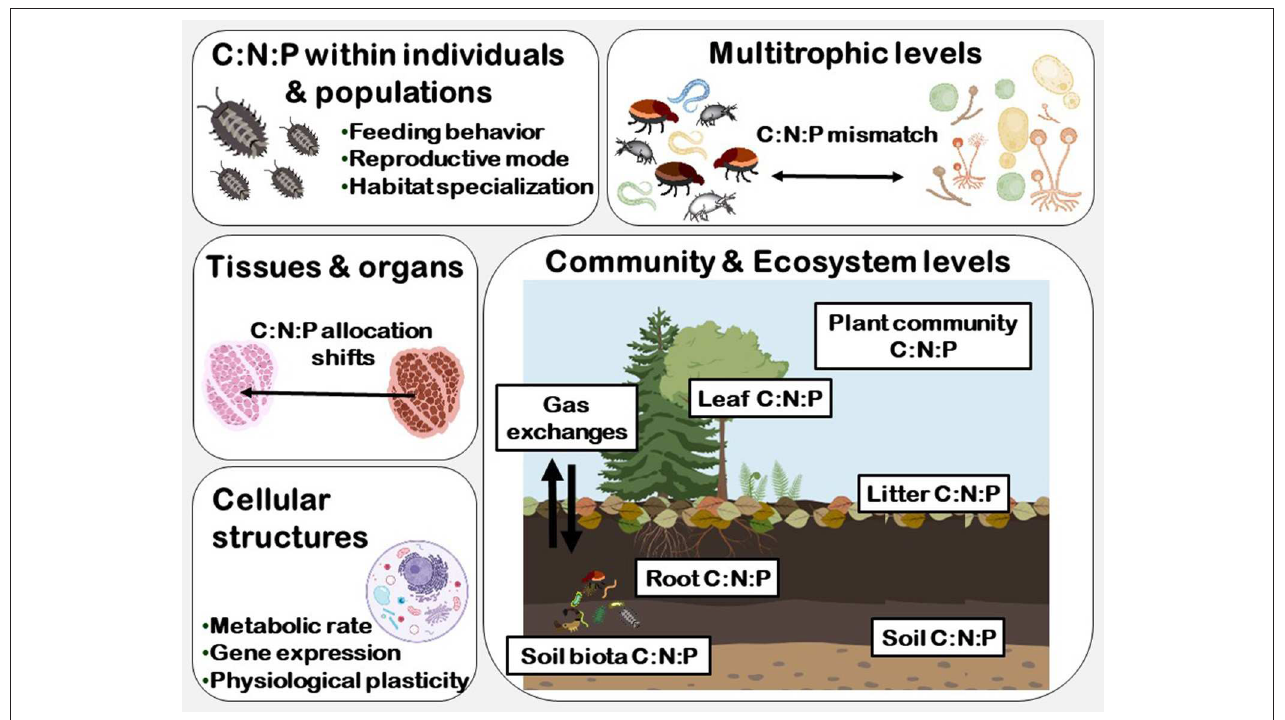
FIGURE 1 | The different biological levels of organization and the relationships of the carbon: nitrogen: phosphorus stoichiometry of primary producers and soil biota.